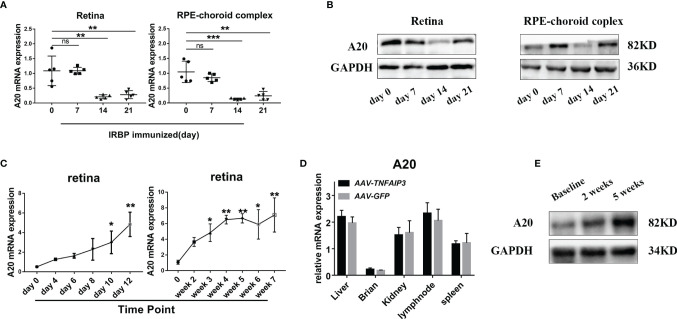
A20 overexpression in the intraocular tissue by AAV-TNFAIP3 injection. (A) Relative mRNA expression of A20 in the retina and choroid-complex from EAU mice in different periods by RT-qPCR (n≥4 per group). (B) The protein level of A20 in the retina and choroid-complex from EAU mice in different periods was tested by Western-blot. (C) The expression of A20 in the retina after injecting AAV-TNFAIP3 was tested by RT-qPCR (n=4 per group). (D) The expression of A20 in the other organs after injecting AAV-TNFAIP3 was tested by RT-qPCR (n=4 per group). (E) The protein level of A20 in the retina after injecting AAV-TNFAIP3 was detected by immunoblot. Data are shown as mean ± SD. One-way ANOVA was used for statistical analyis, ns p<0.05, *p<0.05, **p<0.01, ***p<0.001.